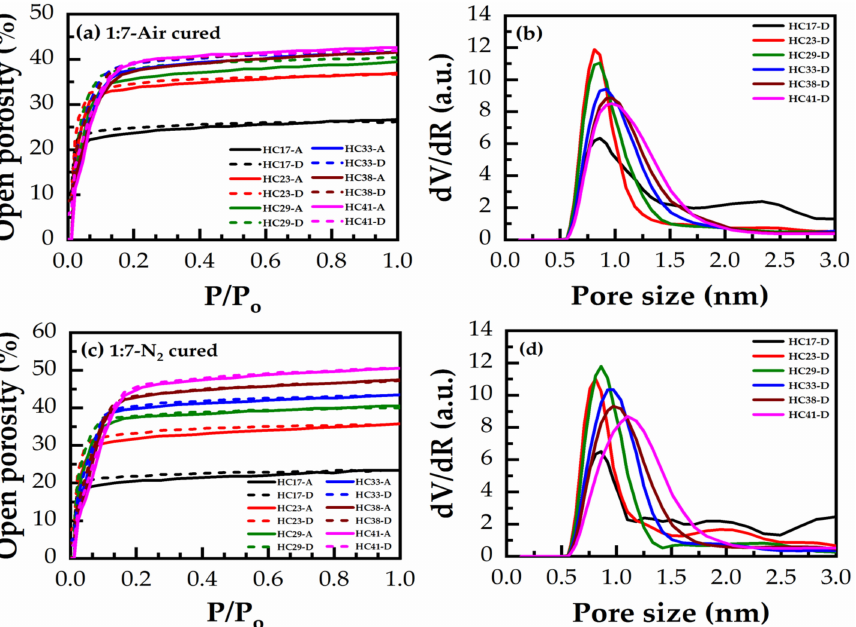
Figure 12. Heptane adsorption (A)/desorption (D) isotherms (heptane relative pressure, P/P o vs open porosity) of 1:7 material ( a ) hard baked in the air for 30 min (air-cured) ( c ) hard baked in N 2 for 60 min (N 2 -cured), and the corresponding pore size distribution (PSD) in ( b , d ), respectively, calculated for desorption (D) isotherms, showing the effect of varying the porogen concentration from 17 to 41 wt% (films numbered from HC17 to HC41).